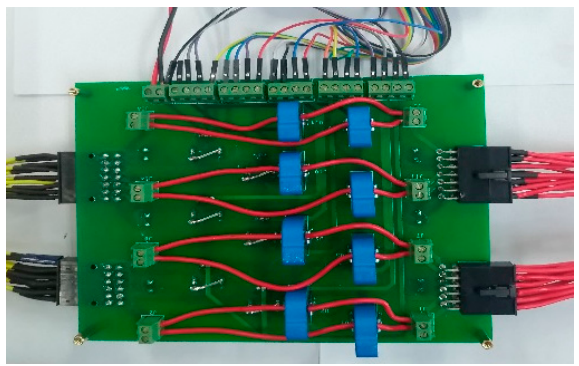
Figure 24. 14-channel Hall-type current sensors.